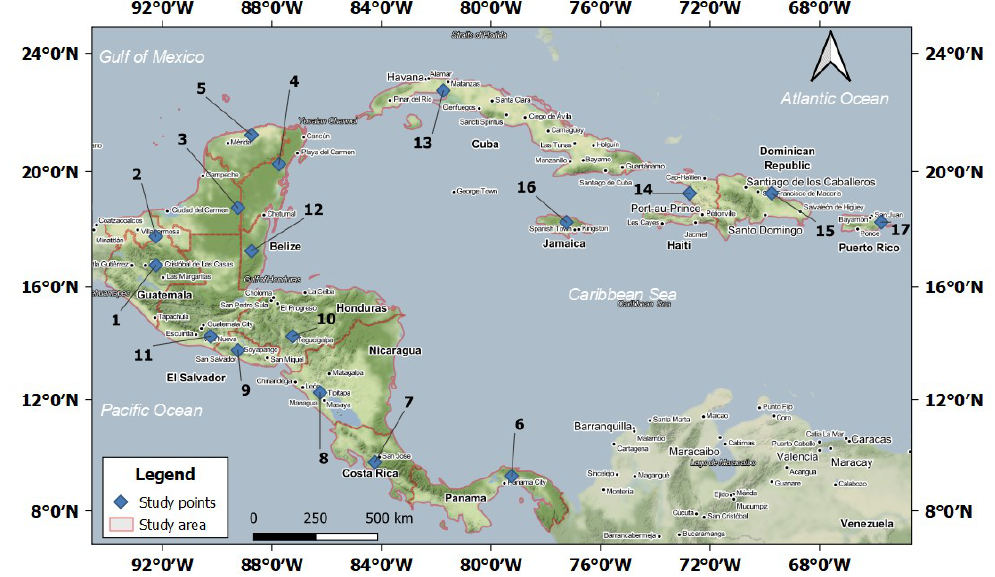
Figure 2. Spatial distribution of the analyzed points (in blue). Southeast Mexico, Central America, and the Caribbean are in green color. Note. The numbers correspond to the study points in Table 2. Table 1. Fifteen Global Coupled Models from CMIP5-IPCC. Table 2. Geographic coordinates of 17 points of the study